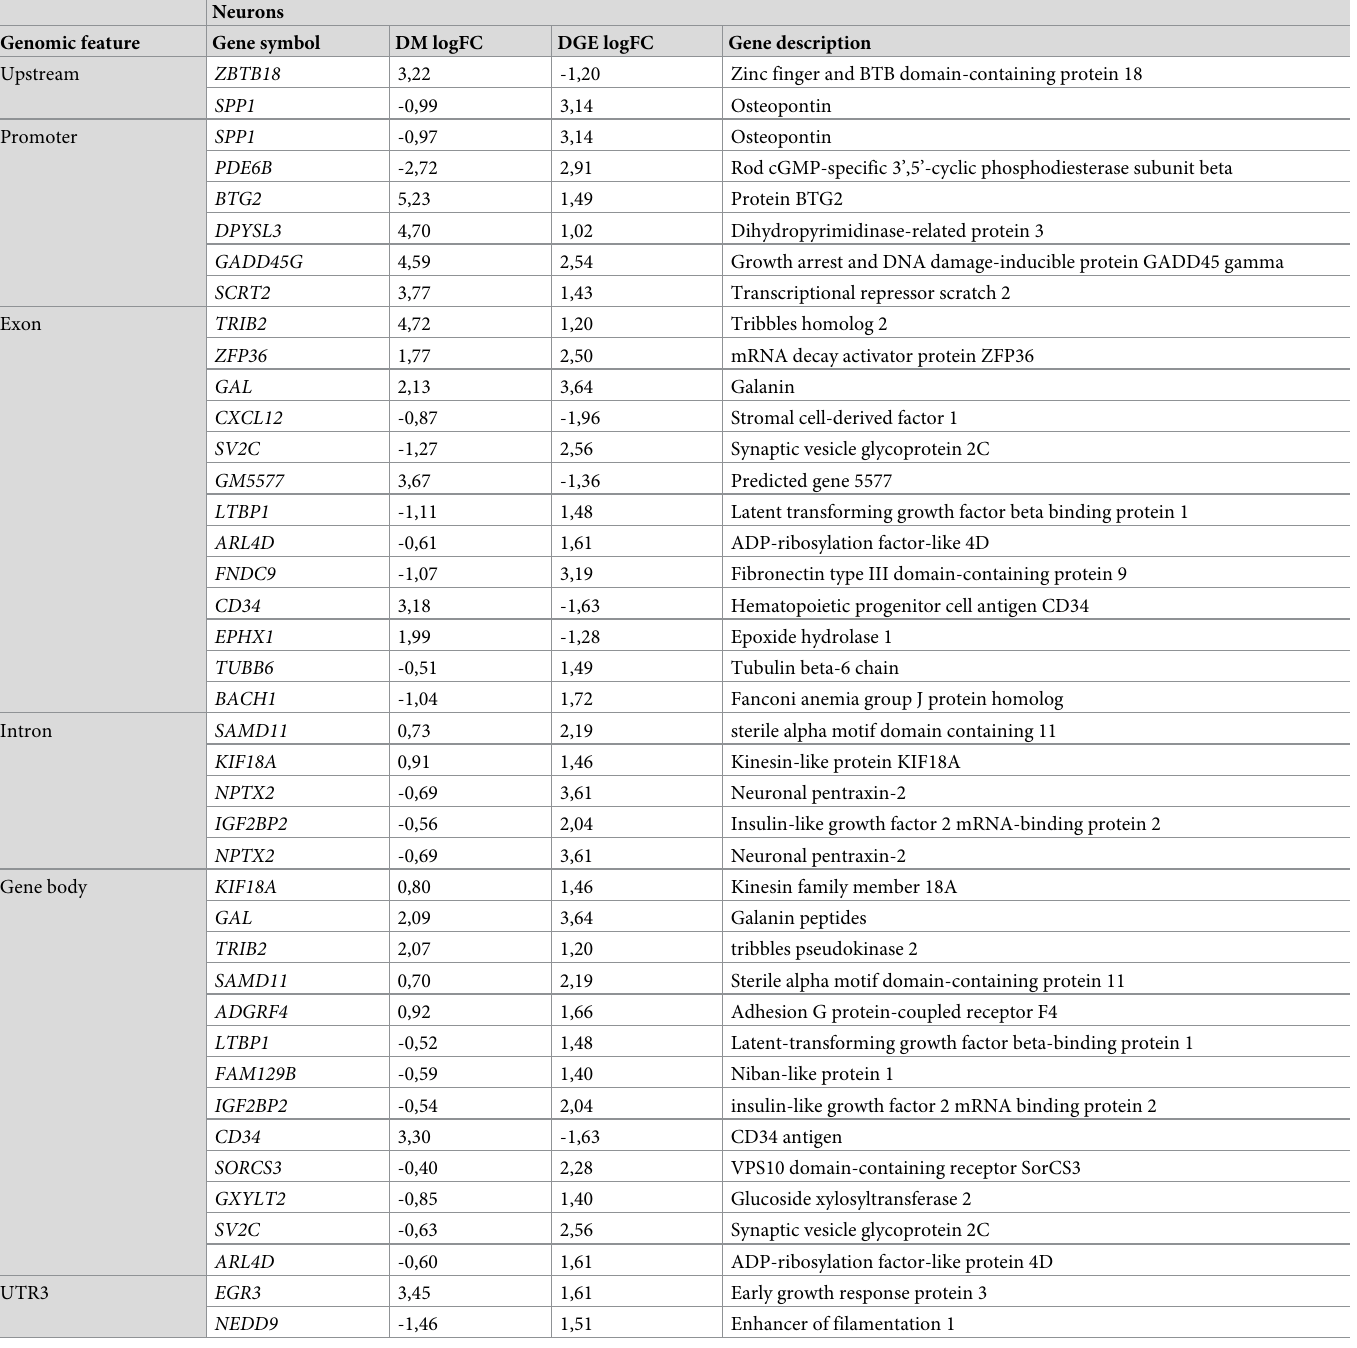
Table 5. Association between DMR and DGE in neurons at 24 hours post injection.